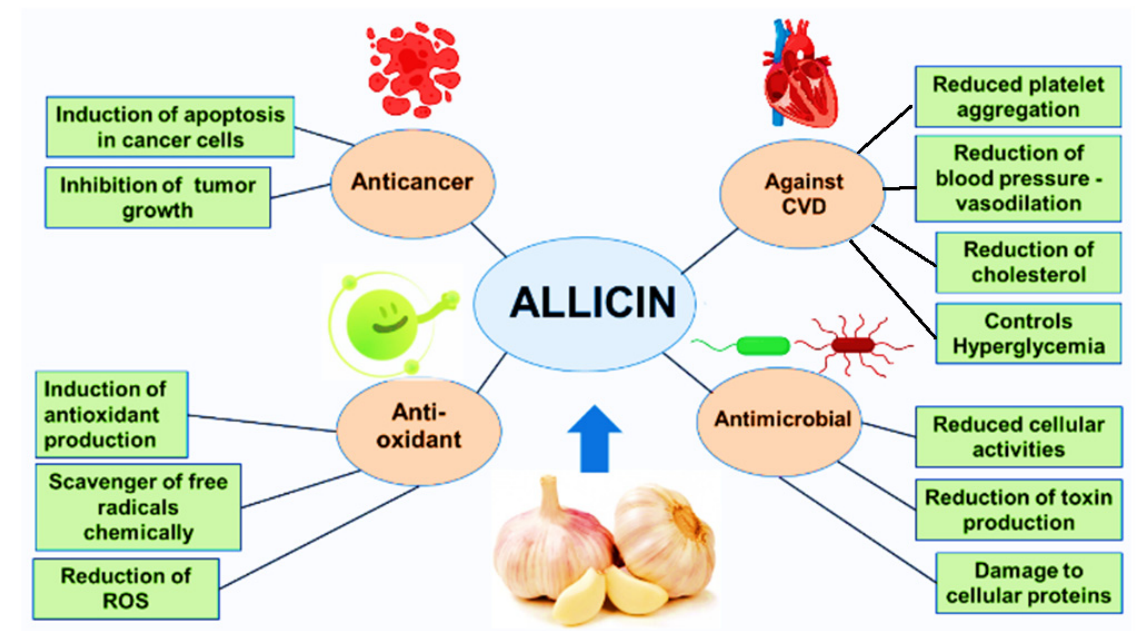
Figure 1. An illustration of general medicinal applications of allicin.